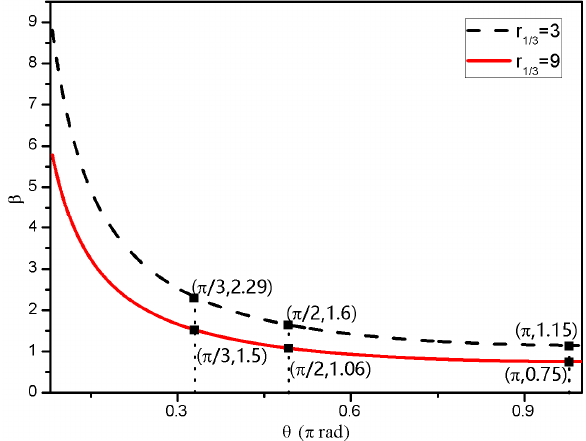
Figure 2. The calculated modulation index β versus the phase difference θ .